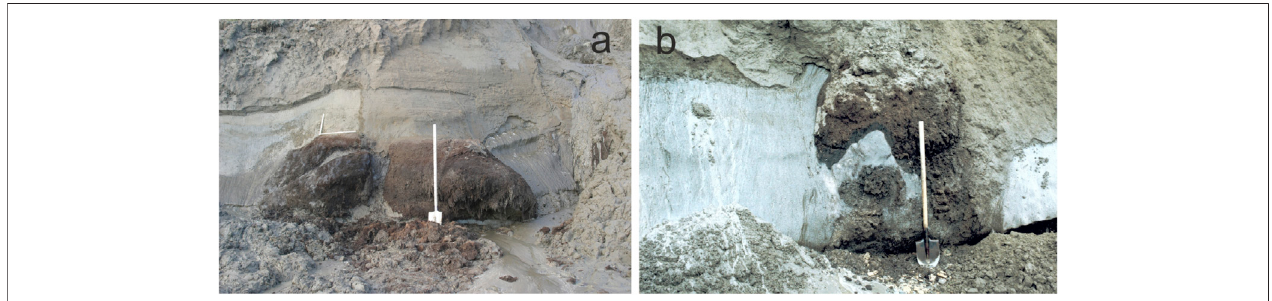
FIGURE 4| Polygonalautochthonous peat lenses with ice wedge generation (A) and with partially thawed Yukagir ice wedges (B) on Bol ’ shoy Lyakhovsky Island.